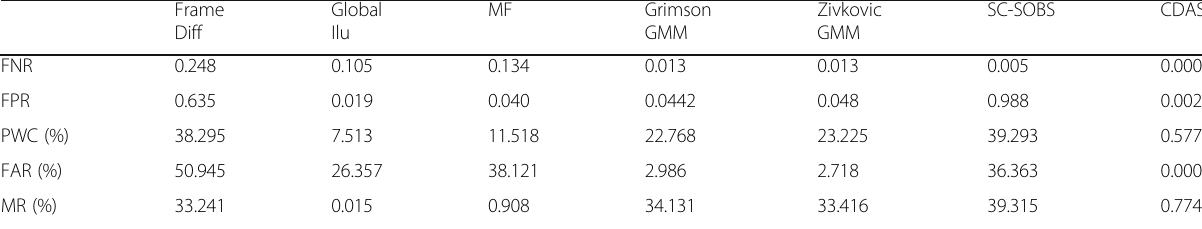
Table 12 Comparison results with the CDnet-2014 “ office ” dataset when the brightness changes Frame Diff